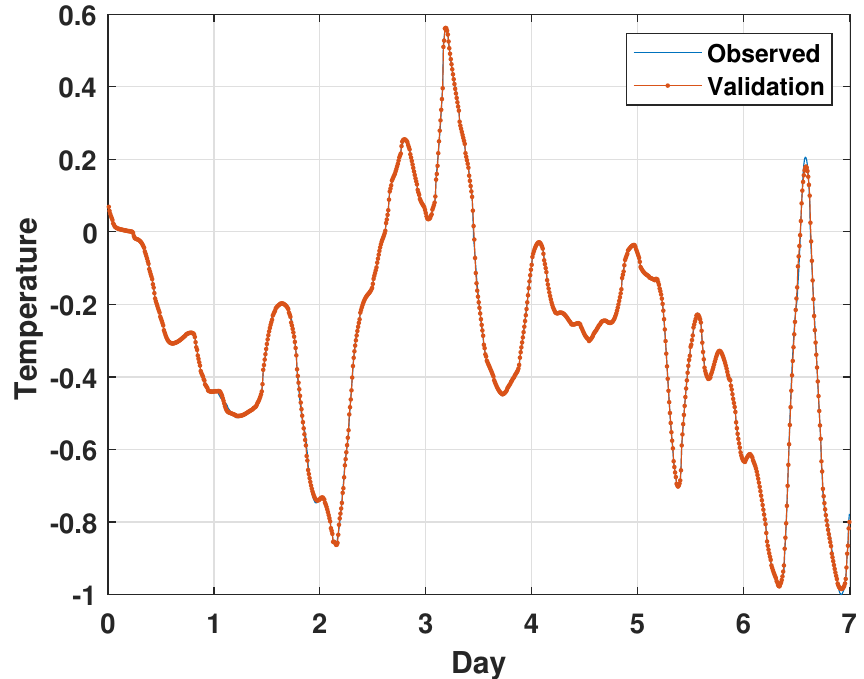
Figure 8. Training and validation of the temperature